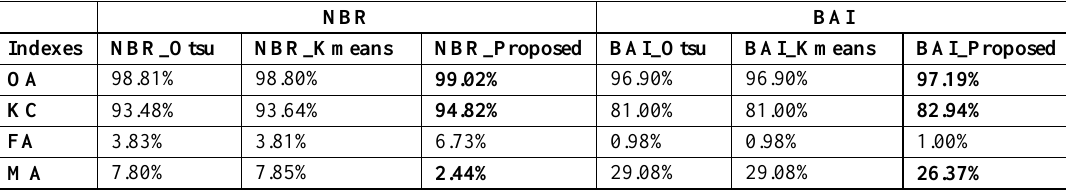
Table 1. Quantitative evaluation results of mapping accuracy of different methods